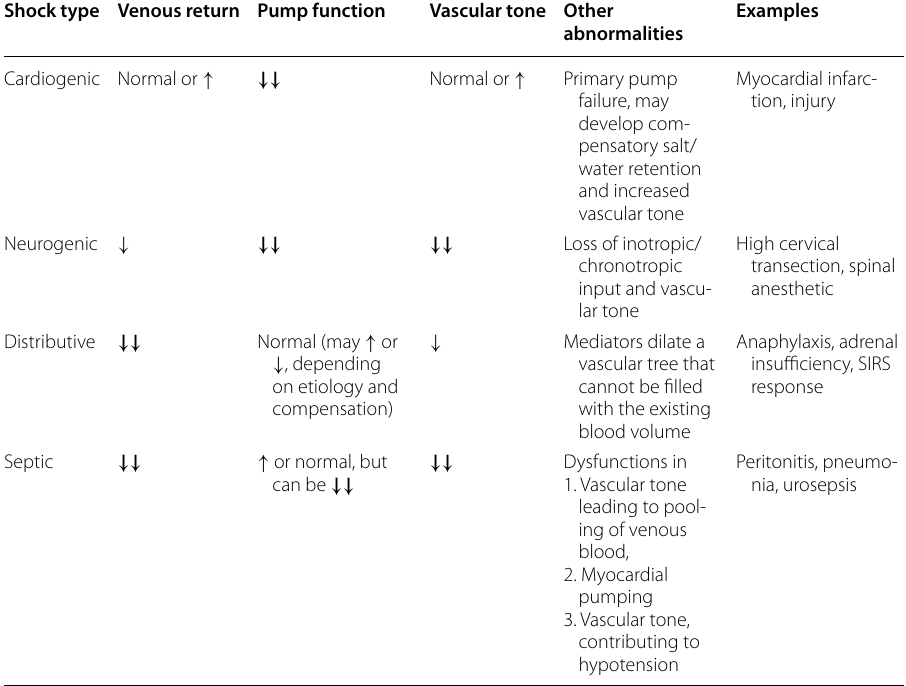
Key abnormalities are indicated by bold double arrow